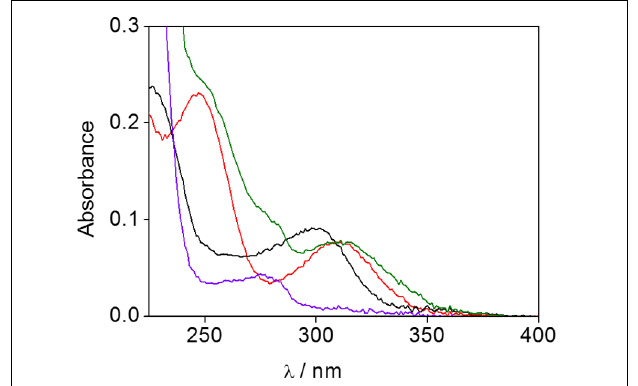
FIGURE 2 | UV-Vis spectra of phosphate buffer solutions of HTB (black), ubiquitin (violet), HTB-ubiquitin adduct (green) and HTB-ButylNH 2 adduct